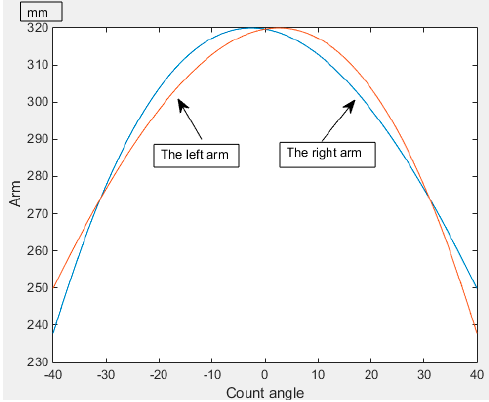
Figure 9. Variation curve of the steering cylinder arm with steering angle.